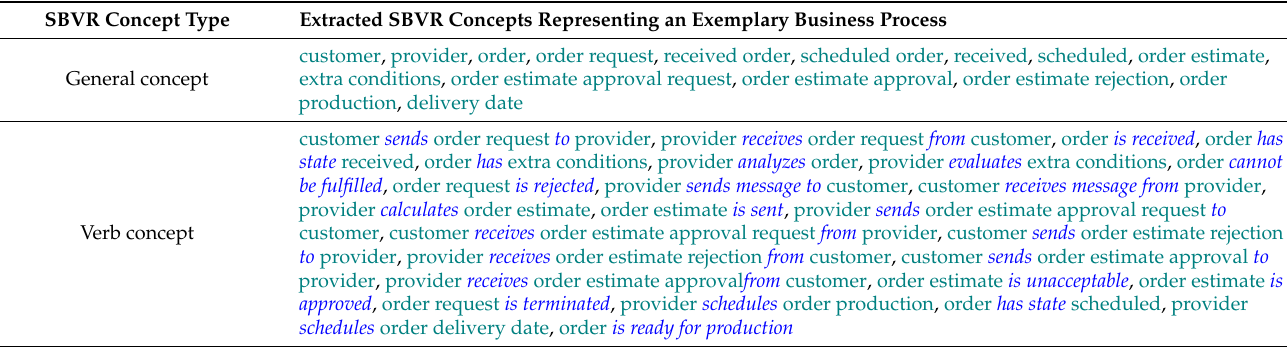
Figure 5. An illustrative example: the business process “Order Registration”. Table 2. An SBVR business vocabulary for the business process “Order